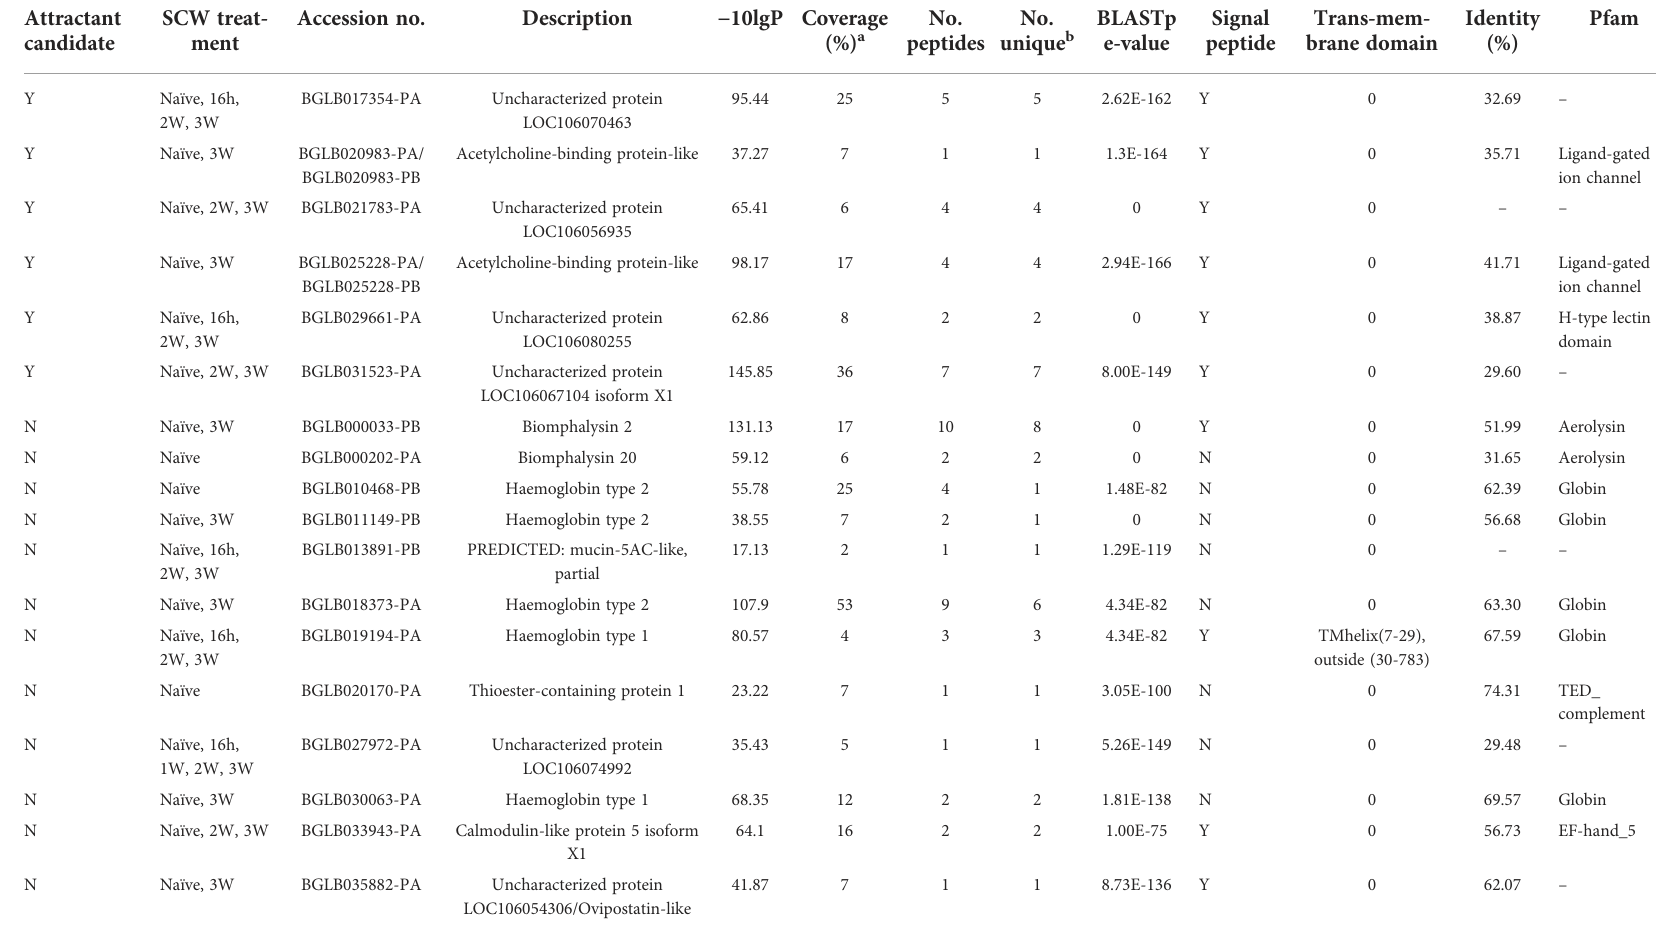
TABLE 3 Attractant candidate ESPs identi fi ed as shared between B. glabrata 3W-PME and naïve SCW, or unique to the latter. Attractant